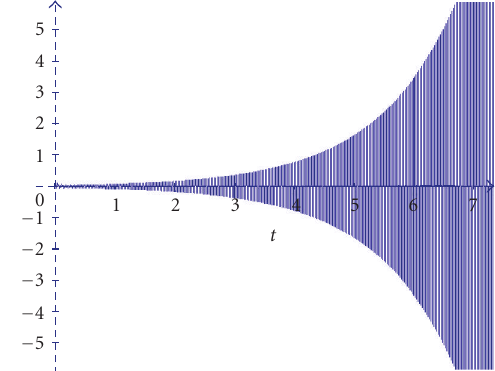
Figure 6.4 . Unstable solution of (5.2) in the point C (540,100), a 0 = 0 .